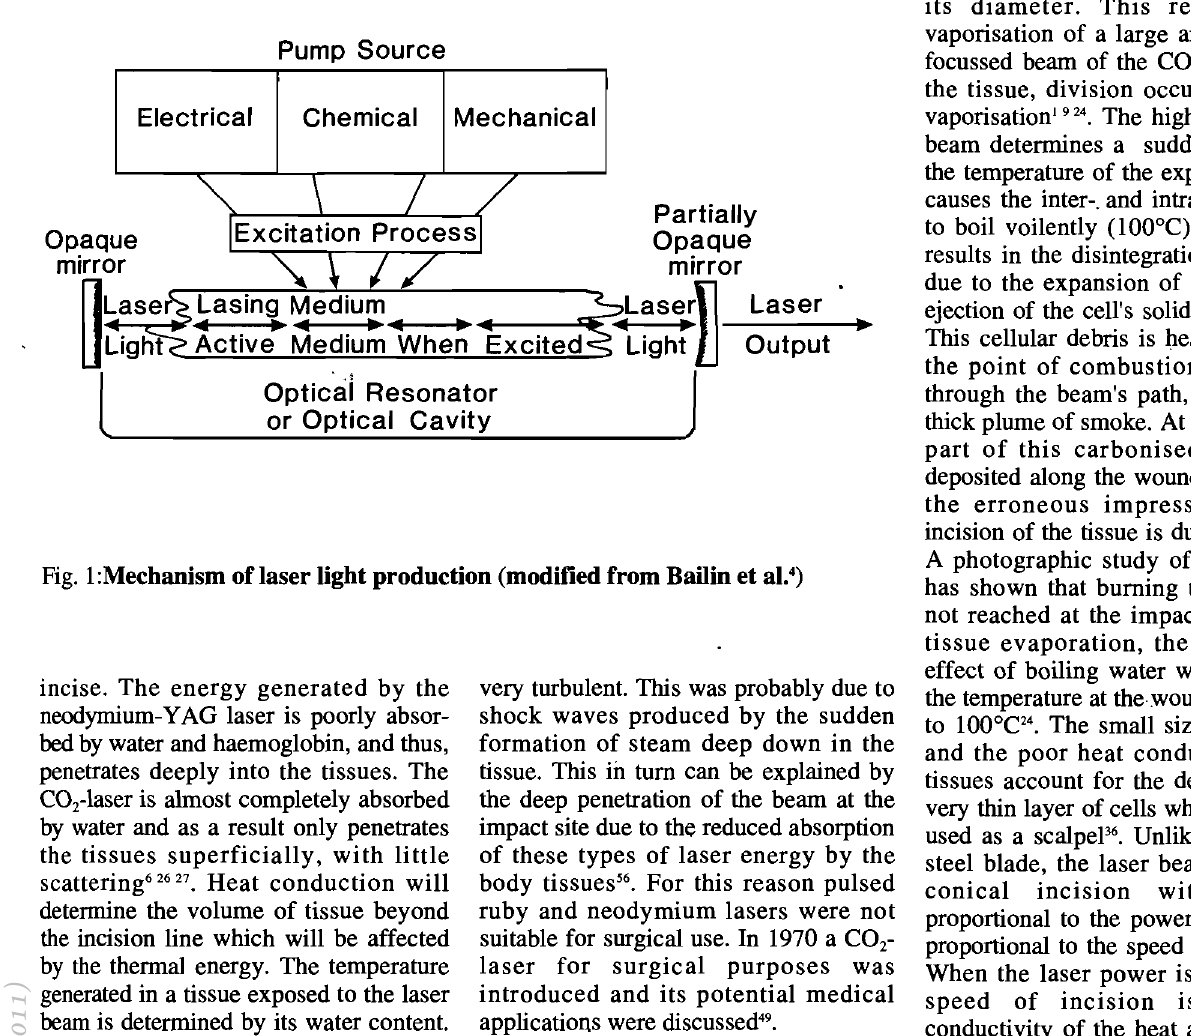
incise. The energy generated by the neodymium-Y AG laser is poorly absor bed by water and haemoglobin, and thus, penetrates deeply into the tissues. The CO -laser is almost completely absorbed 2 by water and as a result only penetrates the tissues superficially, with little scattering6 26 27. Heat conduction will determine the volume of tissue beyond the incision line which will be affected by the thermal energy. The temperature generated in a tissue exposed to the laser beam is determined by its water content. taining the temperature in the interaction site at 100°C1627. Once the water in the tisue has evaporated, the buffer effect will disappear and the temperature will increase substantially. If irradiation is prolonged, carbonisation may occur36 . tiSsues with very low water content, such as bone, can reach 1